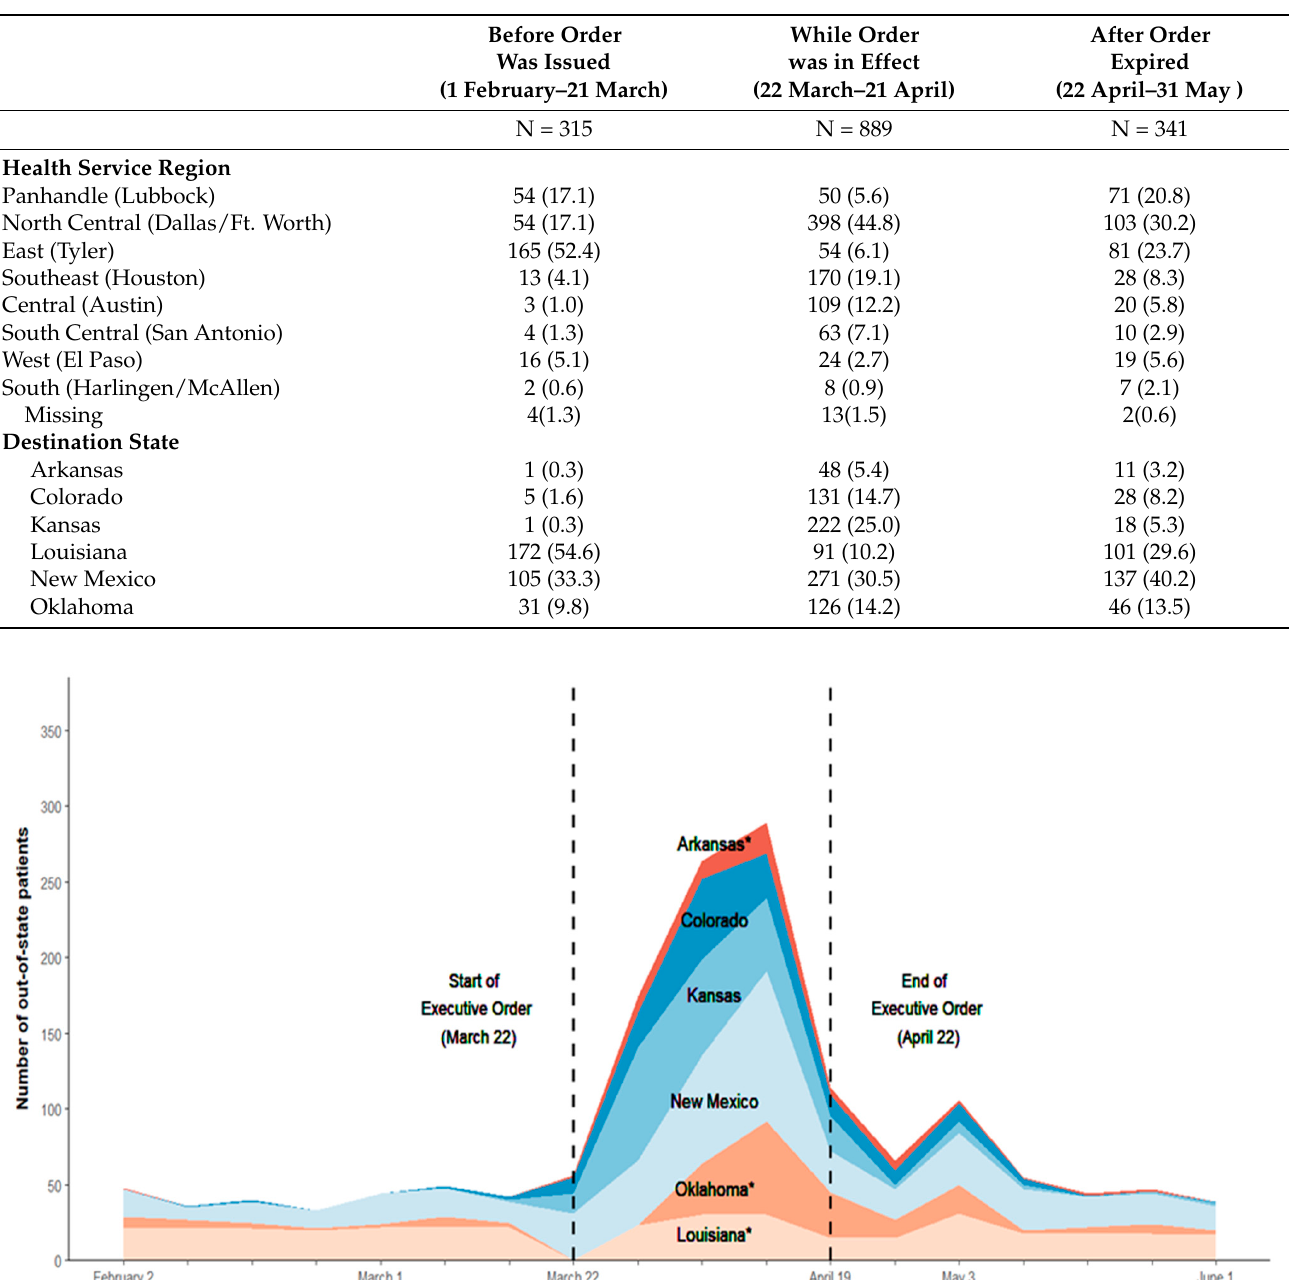
Table 3. Distribution of Texas residents’ region of origin and state where received care, executive